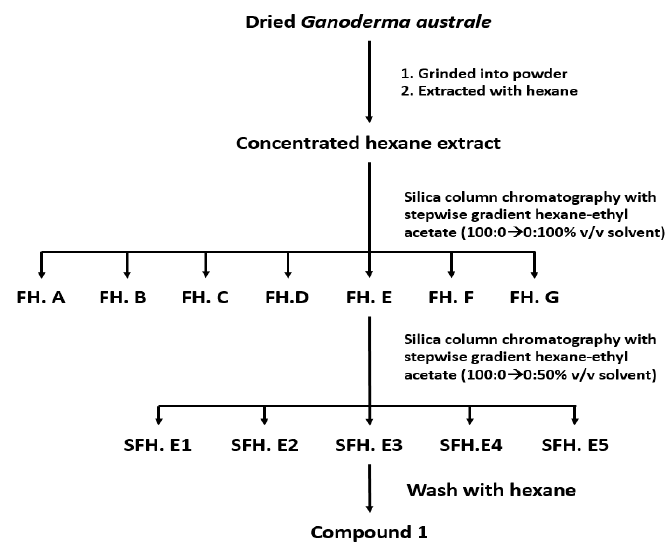
Figure 1. Isolation scheme of stellasterol from G. australe.